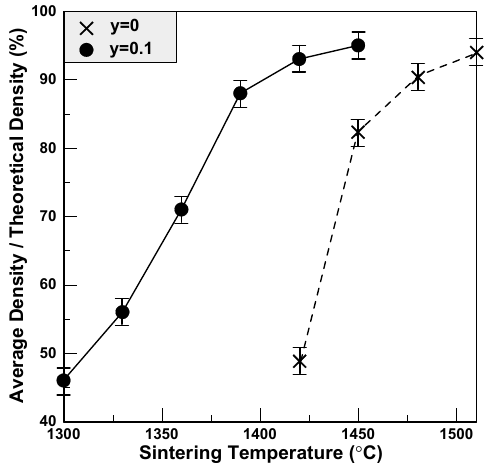
Figure 3. The average density of pure BCTS and BCTS–0.1LiF sheets.